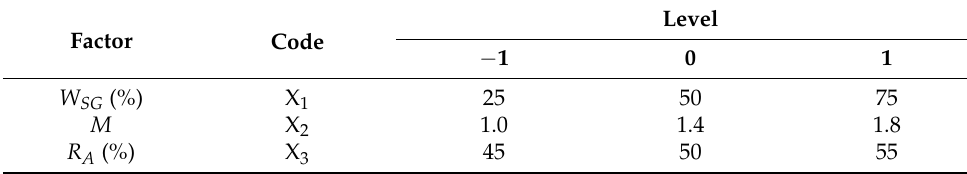
Table 2. Box–Behnken design with three factors and three levels. Factor